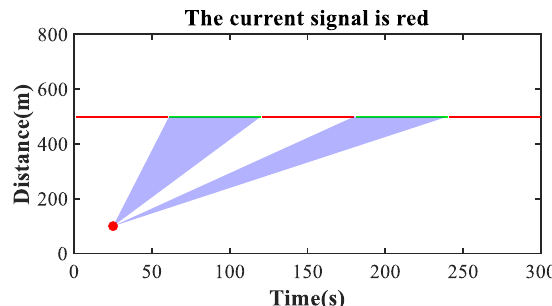
Figure 5. The color of the next target traffic light is red.